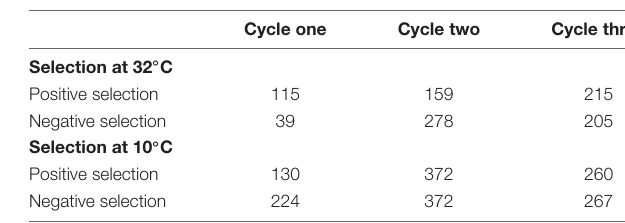
TABLE 1 | Number of individuals (from 1000 seeds) intercrossed at each cycle of the divergent selections.